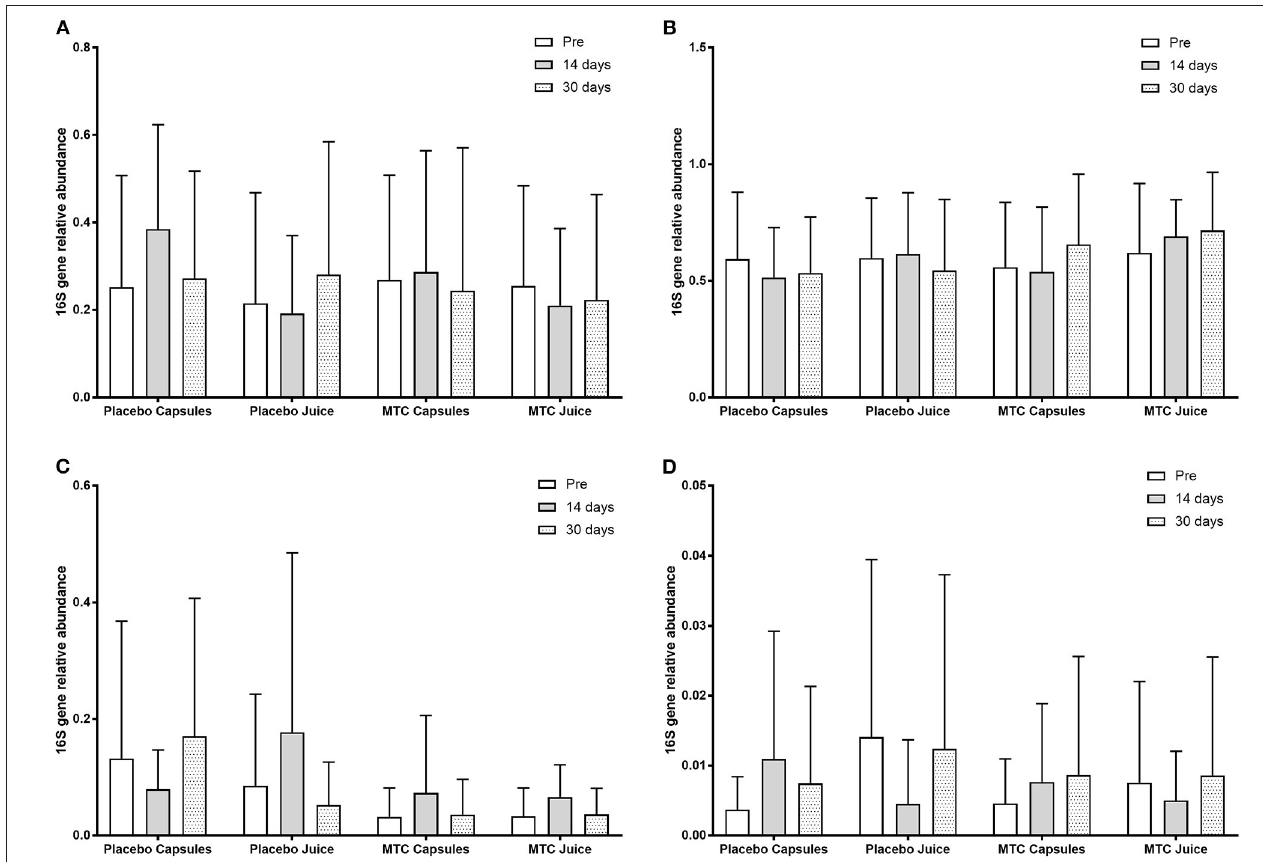
FIGURE 3 | Observed taxonomic units (OTUs) for (A) Bacteroides, (B) Firmicutes, (C) Actinobacteria, and (D) Proteobacteria at baseline and after 14 and 30 days of supplementation with placebo or Montmorency tart cherry (MTC).